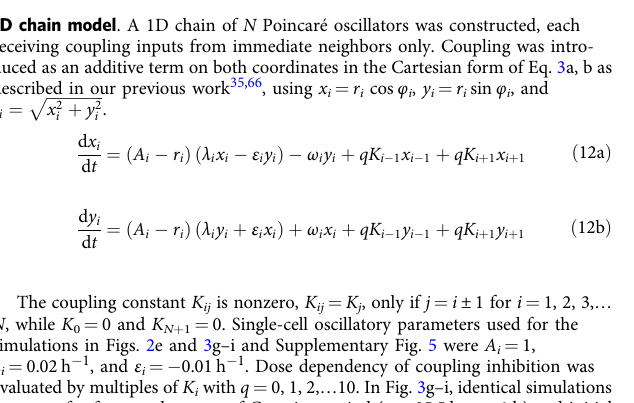
Fig. 13, each cell coupled to neighbors within a certain distance with the same